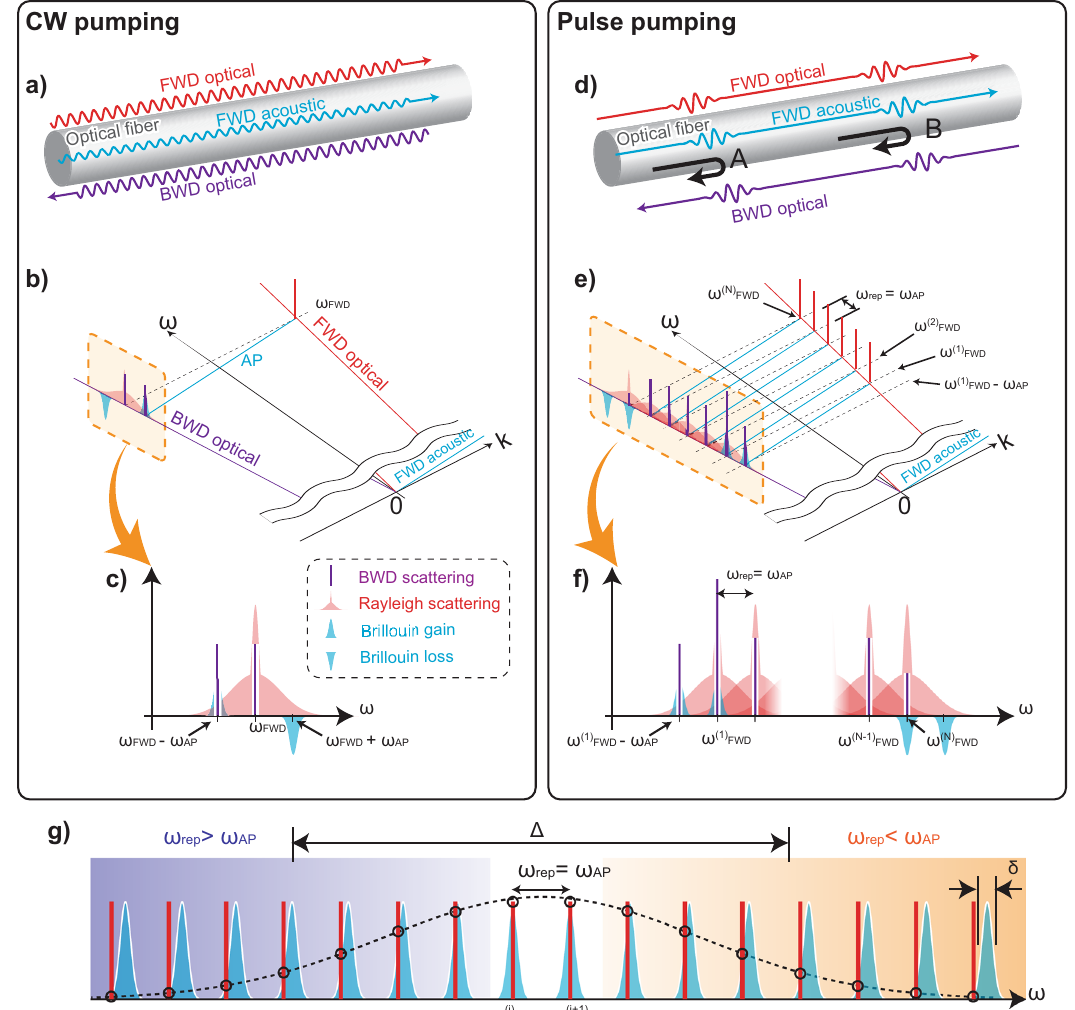
Fig. 1 Conceptual images of Brillouin scattering in a fi ber and dispersion diagrams (not to scale) of the light and acoustic waves. In the continuous- wave (CW) pumping case: a – c show the in- fi ber illustration, the dispersion diagram, and the backward (BWD) optical spectrum, respectively. In the pulsed (multi-mode) pumping case: d – f show the in- fi ber illustration, the dispersion diagram, and the BWD optical spectrum, respectively. Red lines: forward (FWD) optical waves or comb teeth; purple lines: BWD optical waves or comb teeth; sky blue lines: FWD acoustic waves or longitudinal modes. In b , c , e , f , the areas indicated in red are the Rayleigh scattering components with wings and the areas in sky blue denote the Brillouin gain(s) and loss(es) due to the FWD acoustic waves. g Relaxed phase-matching condition. The repetition frequency ω rep is kept constant, while ω AP , represented by the blue Brillouin lines, is sliding with respect to ω FWD due to phase mismatch. The dashed black line with the width of Δ represents the effective Brillouin gain as a function of the optical angular